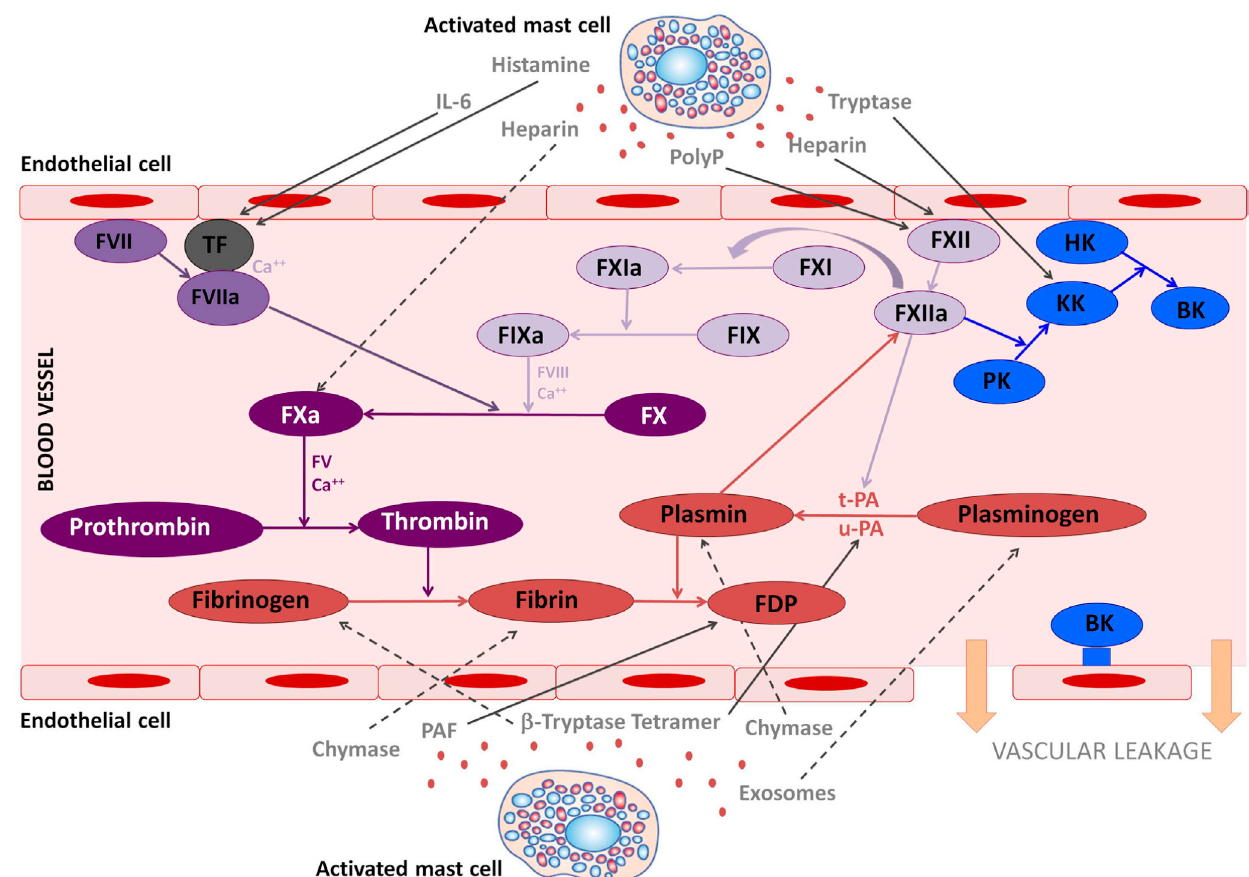
Figure 1. The involvement of mast cell mediators in the coagulation and kallikrein–kinin system. The figure illustrates the effects that mast cells mediators released upon activation during anaphylaxis exert in the kallikrein–kinin, coagulation, and fibrinolytic systems. Solid lines represent activated pathways. Dashed lines are inhibitory pathways. Kinin-forming system factors are represented in blue; the fibrinolytic system is represented in red; the common coagulation pathway in dark purple; the extrinsic coagulation pathway in medium purple; the intrinsic coagulation pathway in light purple. PolyP, polyphosphates; TF, tissue factor; PK, prekallikrein; KK, Kallikrein; BK, bradykinin; HK, high molecular-weight kininogen; tPA, tissue plasminogen activator; uPA, urokinase plasminogen activator; FDP, fibrin degradation products; PAF, platelet-activating factor. (Legend and figure adapted from [16]).